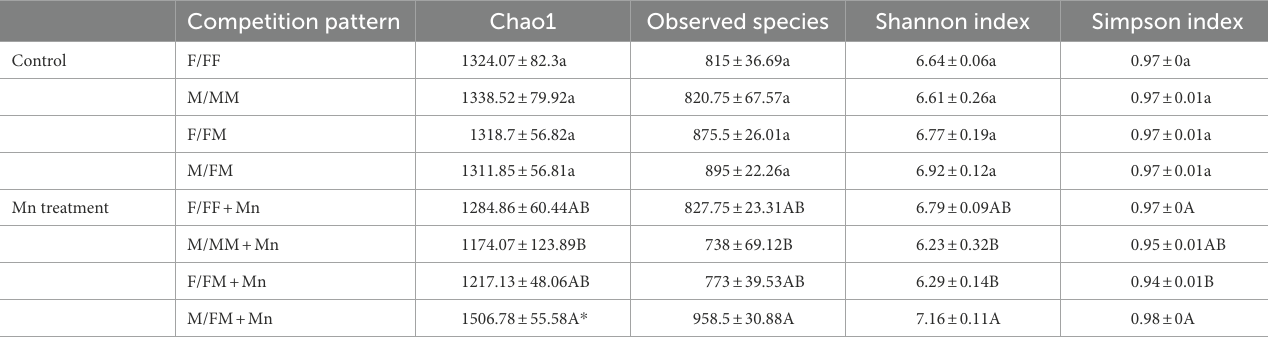
TABLE 2 Alpha diversity of fungi from the rhizospheric soil of Hippophae rhamnoides under different sexual competition patterns and Mn treatments. Competition